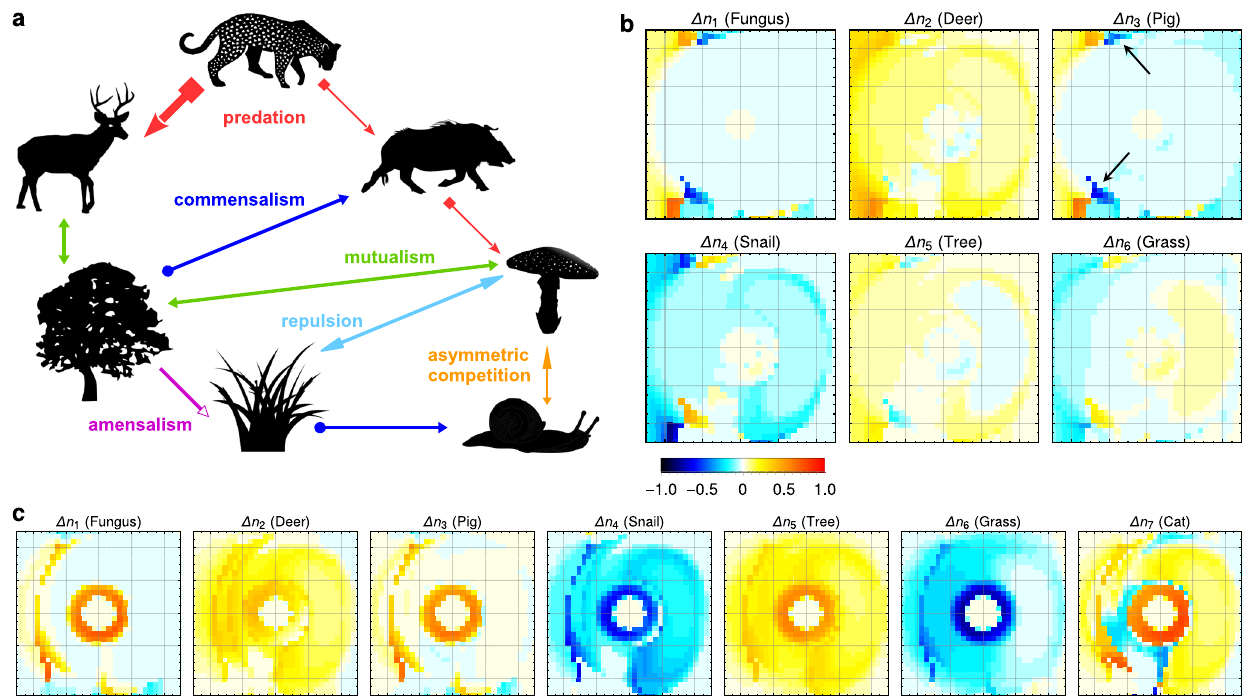
Fig.6|AnapplicationtoahypotheticalfoodwebdemonstratesDFTe ’ sabilities to make predictions about the effects of perturbations on complex ecosys- tems. a The cartoon illustrates the food web involving seven hypothetical species on a synthetic landscape with heterogeneous environmental suitability and resource availability (Supplementary Table 4 and Supplementary Fig. 11). b The six sub-panels depict the relative changes of species distributions following the extermination of the Cat (see graphical legend; redder colours indicate increasing